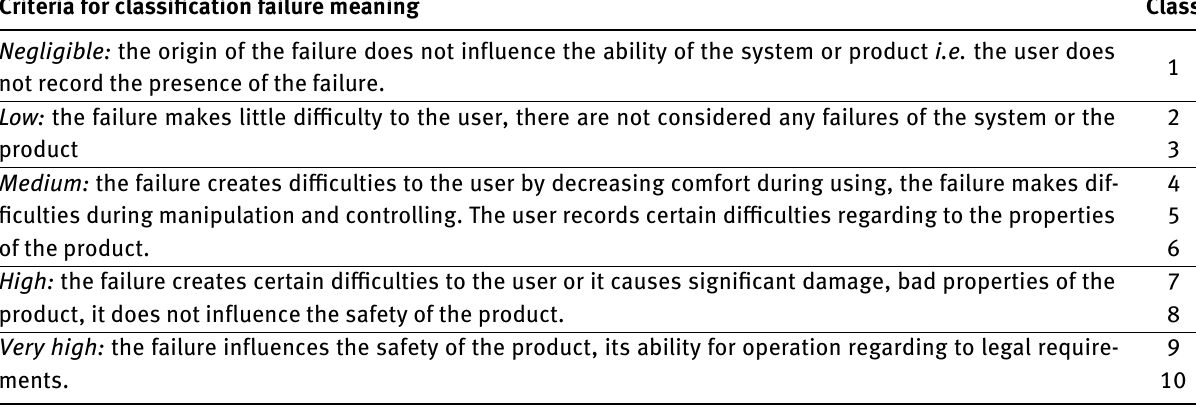
Table 2: Failure meaning Criteria for classification failure